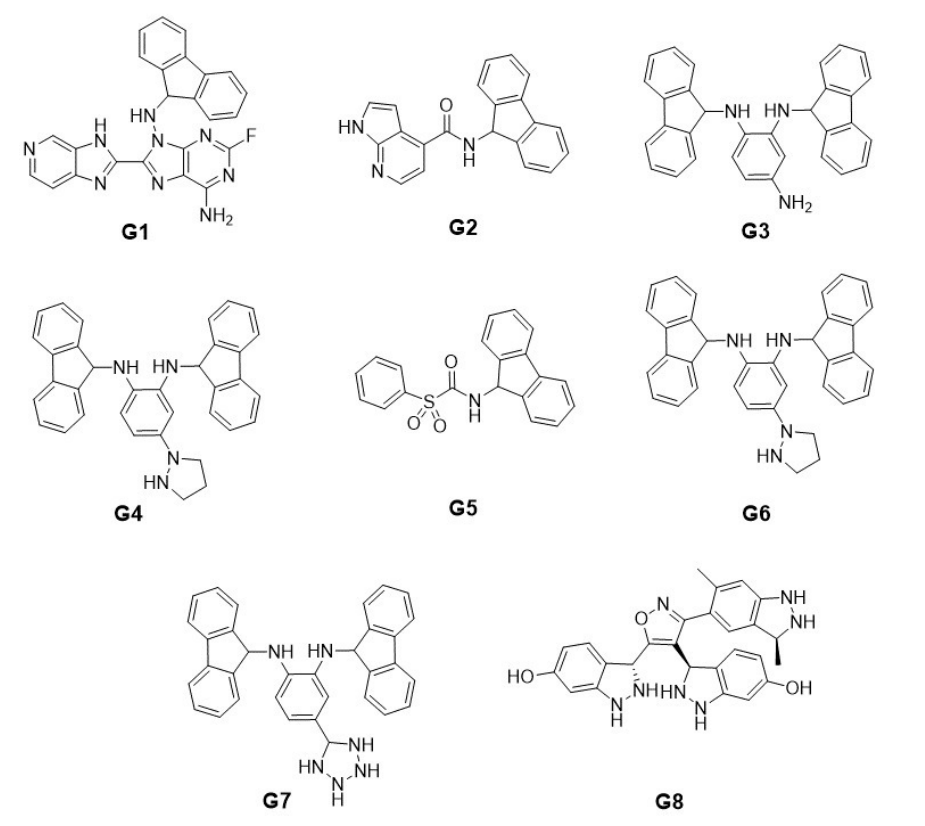
Figure 8. New ligand structures with the best binding energy obtained with the semi-exhaustive approach for each